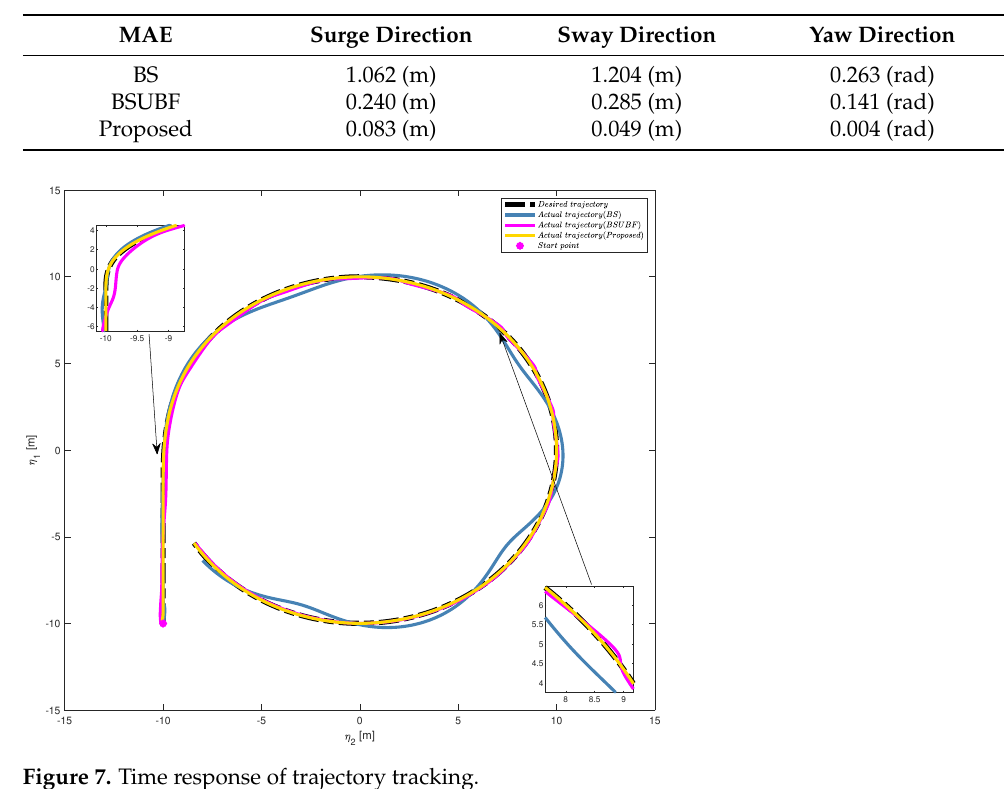
Table 3. Maximal absolute tracking errors (MAEs).